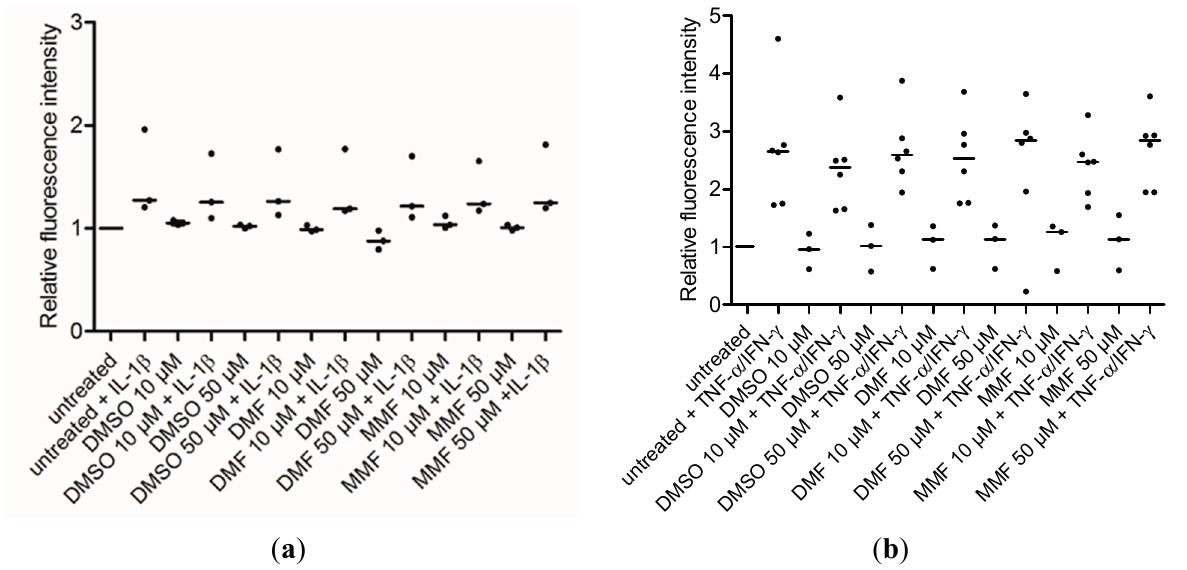
Figure 3. FAE do not reduce T-cell adhesiveness of HBMEC under basal and inflammatory conditions. Confluent HBMEC were stimulated in analogy to Figure 2, using IL-1 β ( a ) or TNF- α plus IFN- γ ( b ) as inflammatory stimuli. Subsequently, adhesion of calcein-labeled, PMA-activated Jurkat T cells was assessed in a static adhesion assay. Adhesion of Jurkat T cells, corresponding to the measured fluorescence intensities, is shown relative to untreated cells. Dots represent means of single independent experiments in octuplicates, bars represent